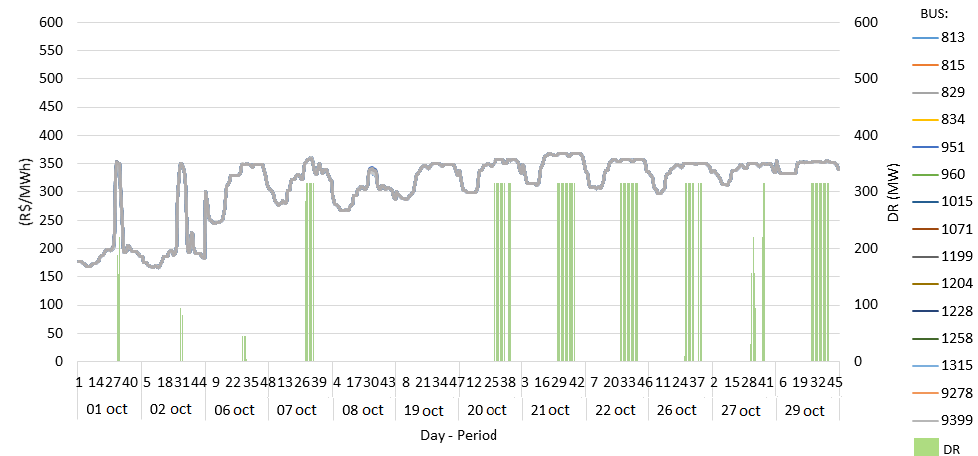
Figure 6. South BMC values and related buses with DR